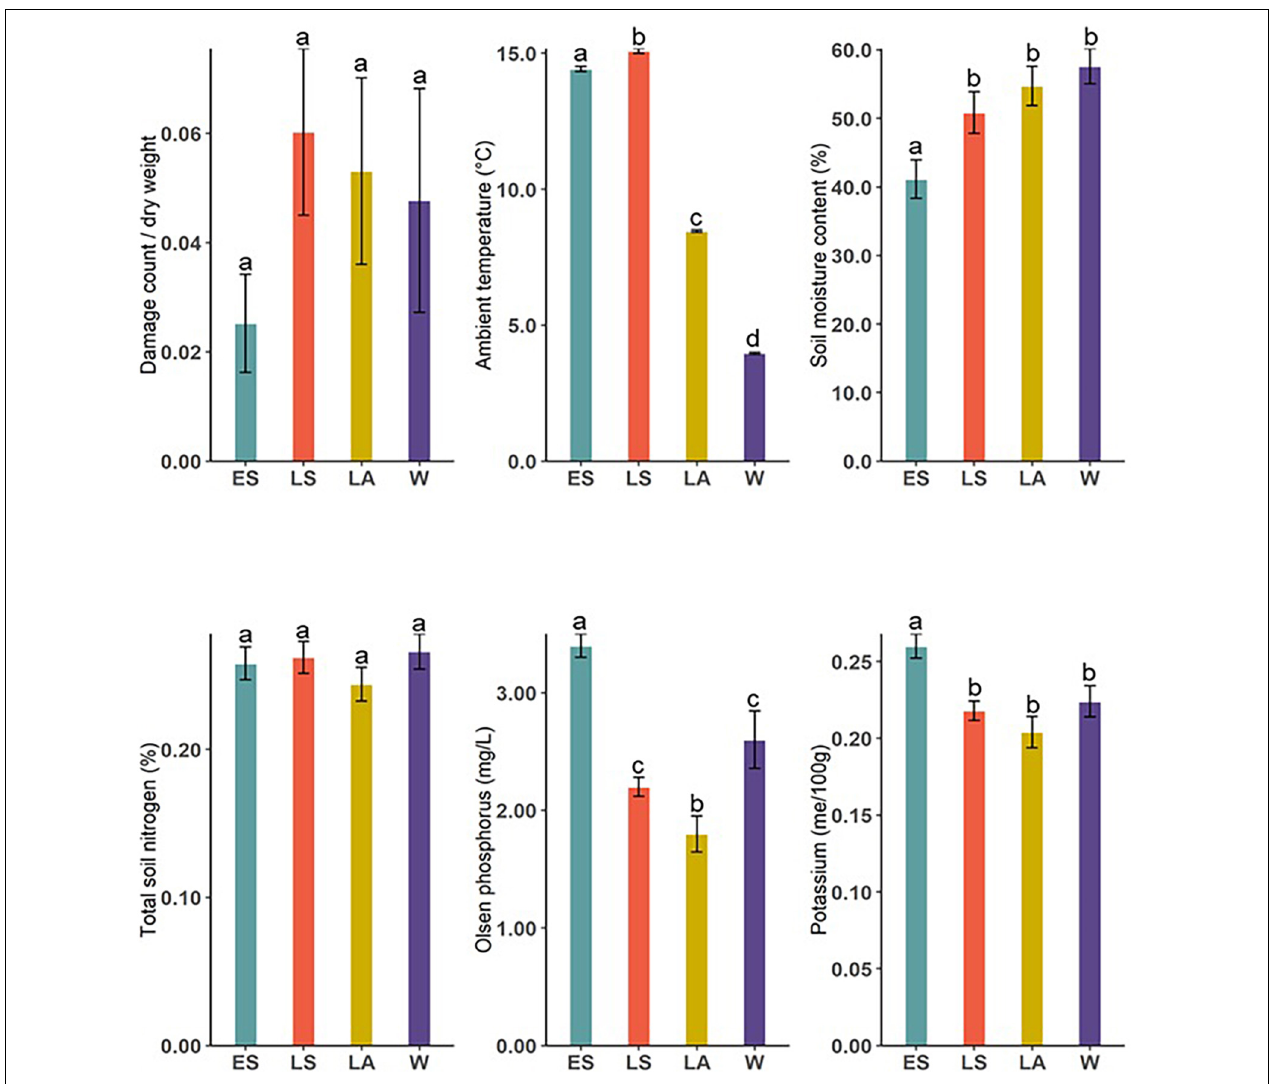
FIGURE 5 | Comparison of measured environmental variables between ES, LS, LA, and W. Bars show mean ± SE of measured variables. Different letters indicate significant differences between